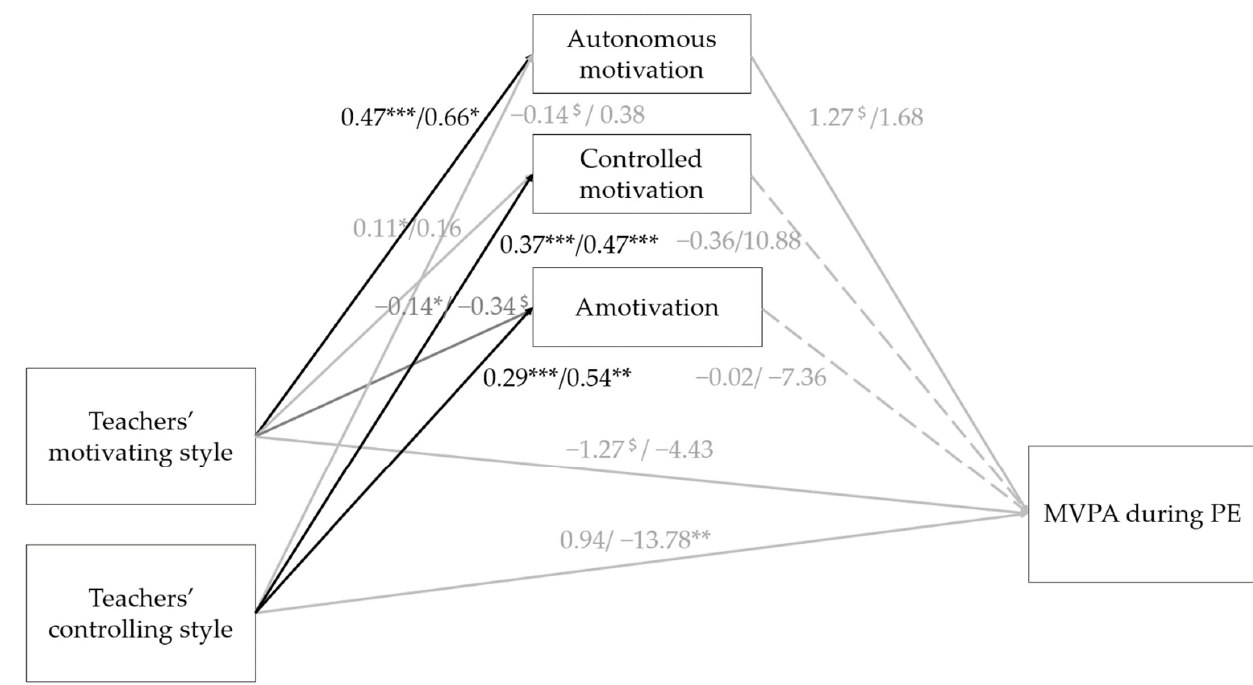
Figure 1. Full model with teachers’ (de-)motivating style as a possible predictor for students’ MVPA during PE when taking both students’ gender and lesson topic into account. β s are presented at both the student level (first number) and the class level ( β student level/ β class level); $ p < 0.1; * p < 0.05; ** p < 0.01; *** p < 0.001; MVPA moderate- to vigorous-intensity physical activity; PE physical education. Black lines indicate a significant relation on both the student and class level, while gray full lines indicate only a significant or trend to significant relation on one of the two levels. Finally, gray dashed lines indicate that no significant relations were found.